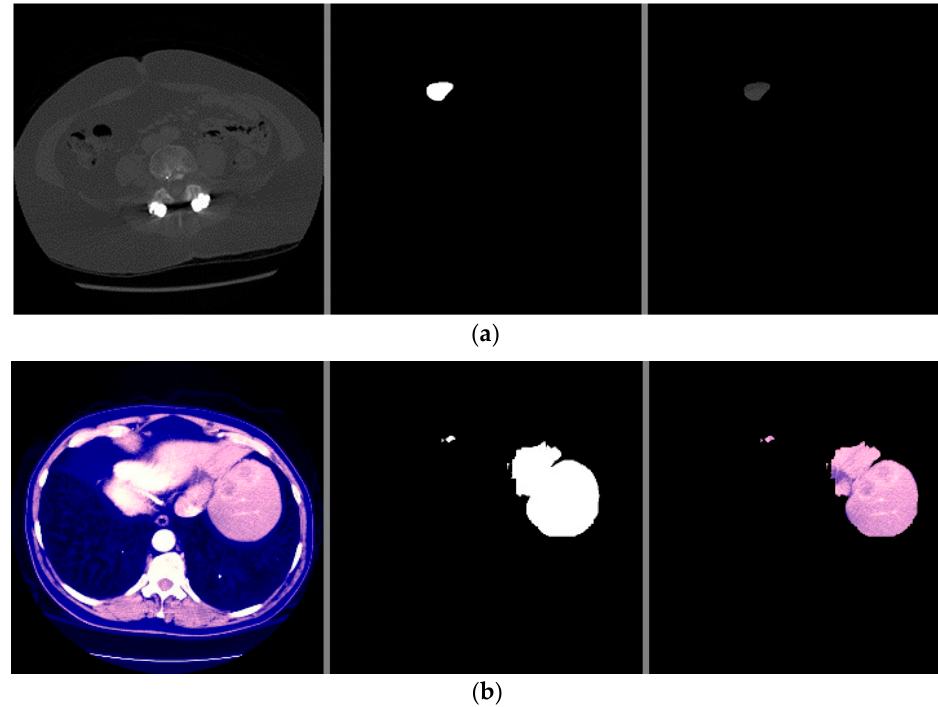
Figure 12. The visual results of the first model for cancer detection on 3D-IRCADb-01 test set: ( a ) normal case (no tumor detection); ( b ) abnormal case (tumor detection). The loss curve of the second model is also shown in Figure 13.